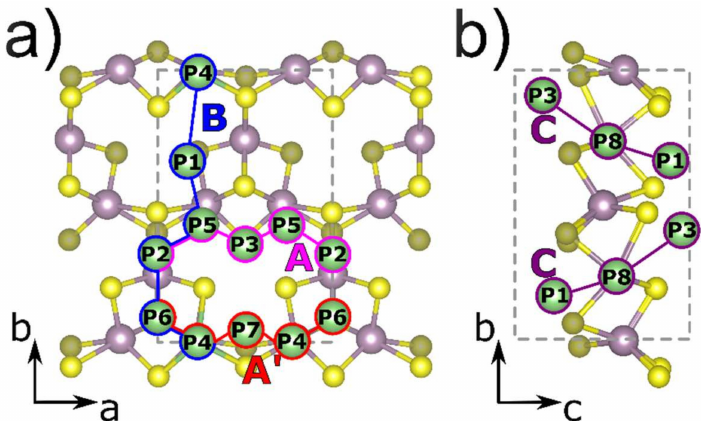
Figure 2. The considered positions of alkali-metal atom (Li, Na) absorption on the surface of the A’-MoS 2 monolayer and the diffusion pathways: ( a ) A (pink) and B (blue), ( b ) C (red) and D (violet). The unit cell is indicated by the grey dashed lines. Mo, S, and alkali-metal atoms (Li, Na) are depicted in purple, yellow, and green colors,